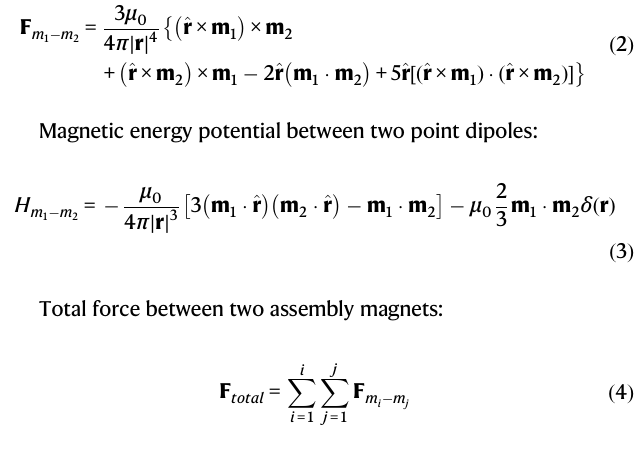
Fig.8|ForcecharacterizationofMaSoChainsassemblyanddisassemblyinside a medical grade thoracic catheter. The pulling/pushing force along the axial direction during the disassembly (panel a ) and assembly (panel b ) are measured. Thepushingandpullingspeedis5mmpersecond.Themeasurementrateis1kHz, but the curve is smoothed with a moving average of the nearest 200 points. The